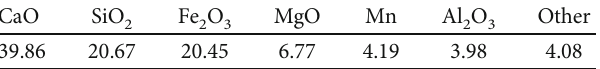
Table 3: Chemical composition of steel slag